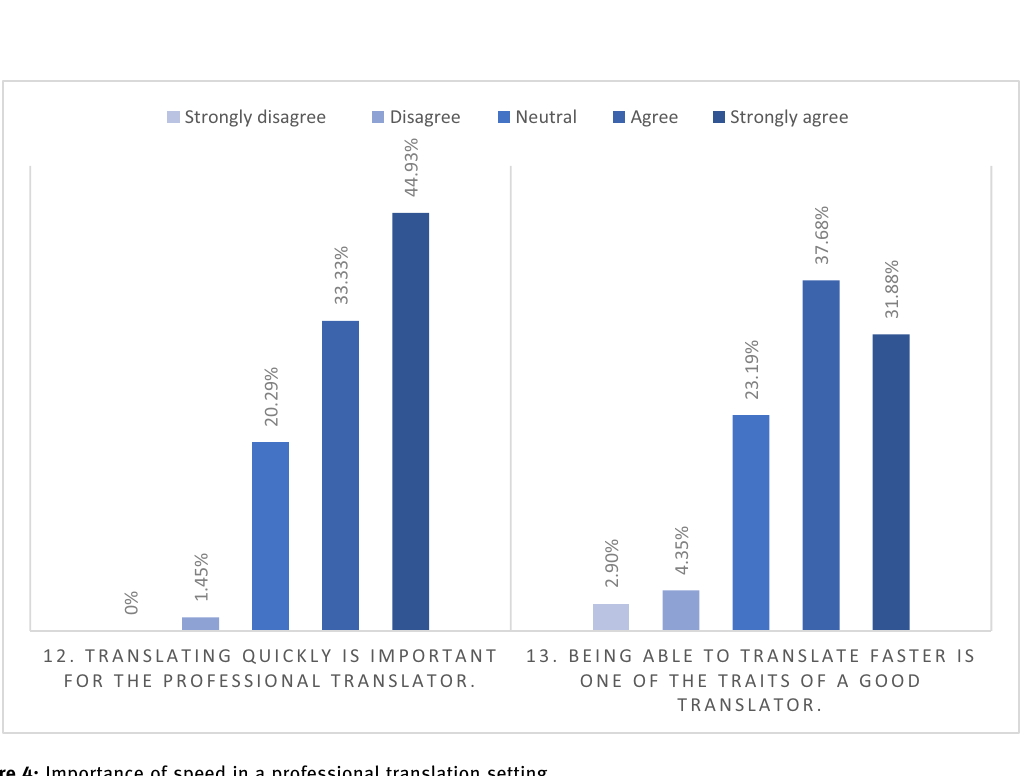
Figure 4: Importance of speed in a professional translation setting.